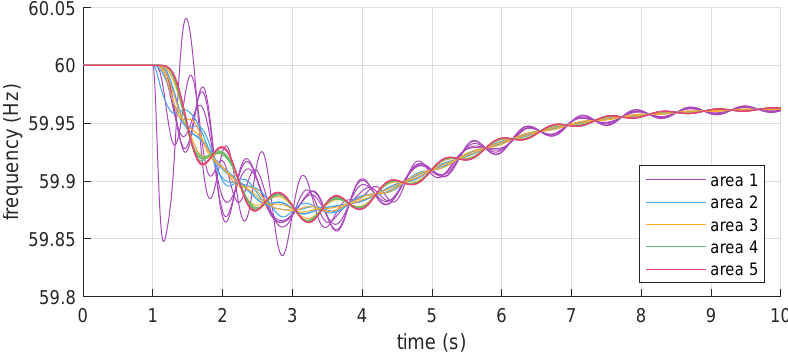
Figure 18. Simulation of the Colombian system: 50%